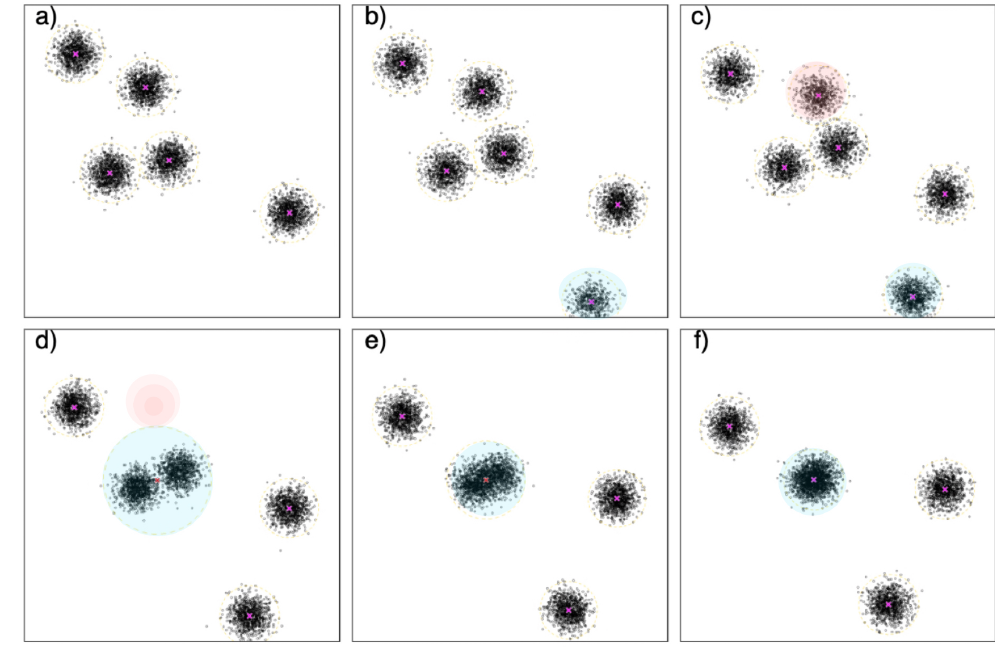
Figure 2. Illustration of changes in data distribution over time. The blue and red spheres around data highlight such changes, where a new data distribution is emerging in ( a – c ) (highlighted in blue), a data distribution disappears in ( c , d ) (highlighted in red), and two data distributions are merging over time in ( d – f ) (highlighted in